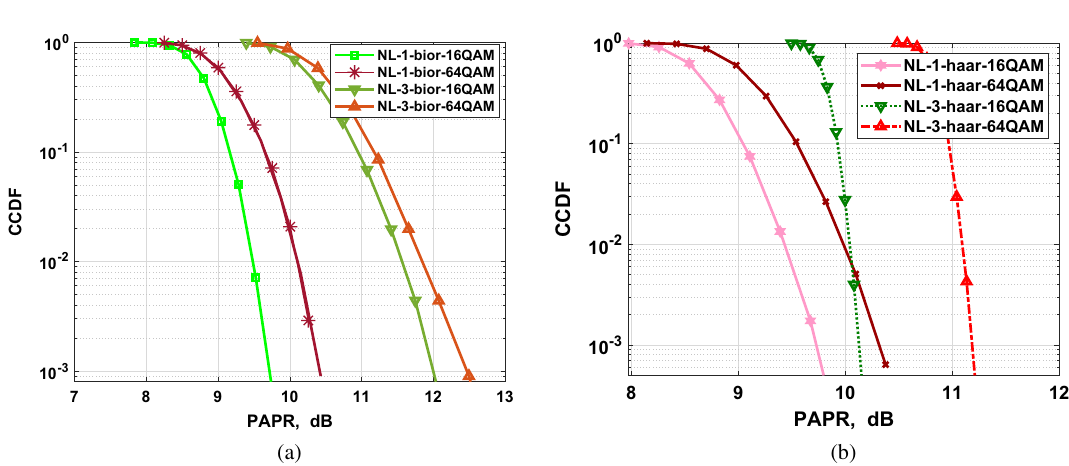
Figure 8. Comparison of PAPRs of F-OWDM with C-F-OFDM and C-OFDM ( a ) using 16-QAM. ( b ) using 64-QAM.